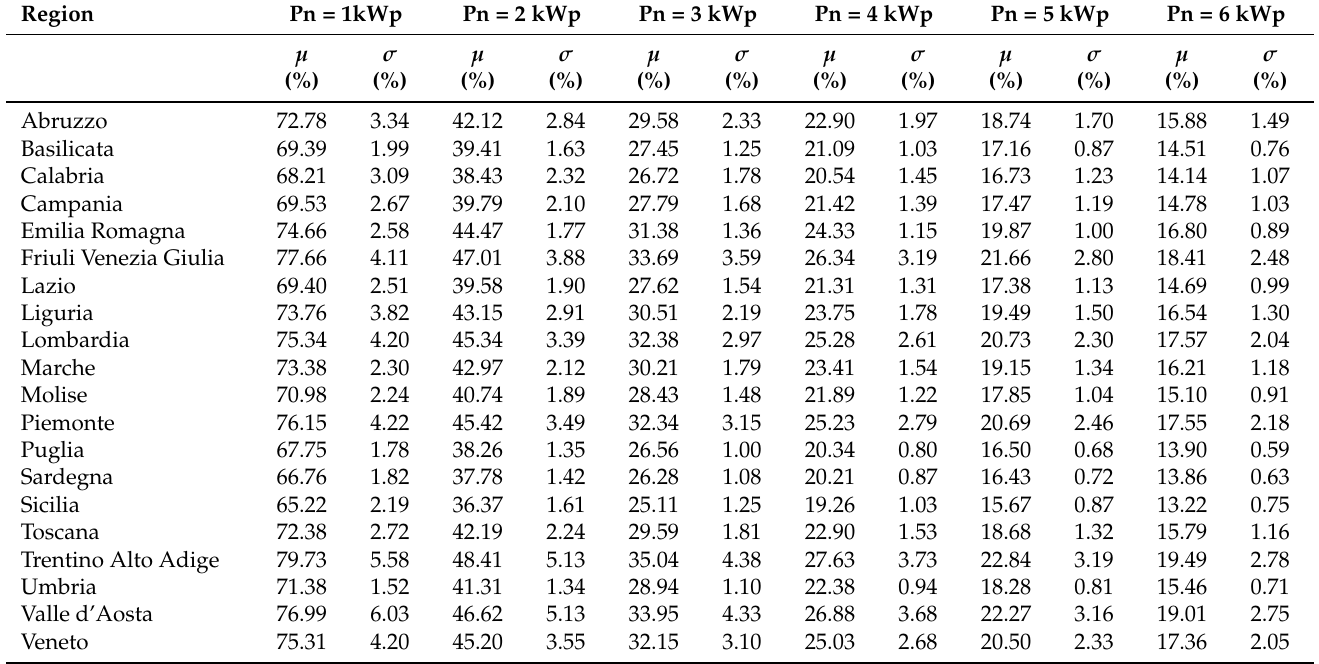
Table 4. Self-Consumption for E L = 2700 kWh without